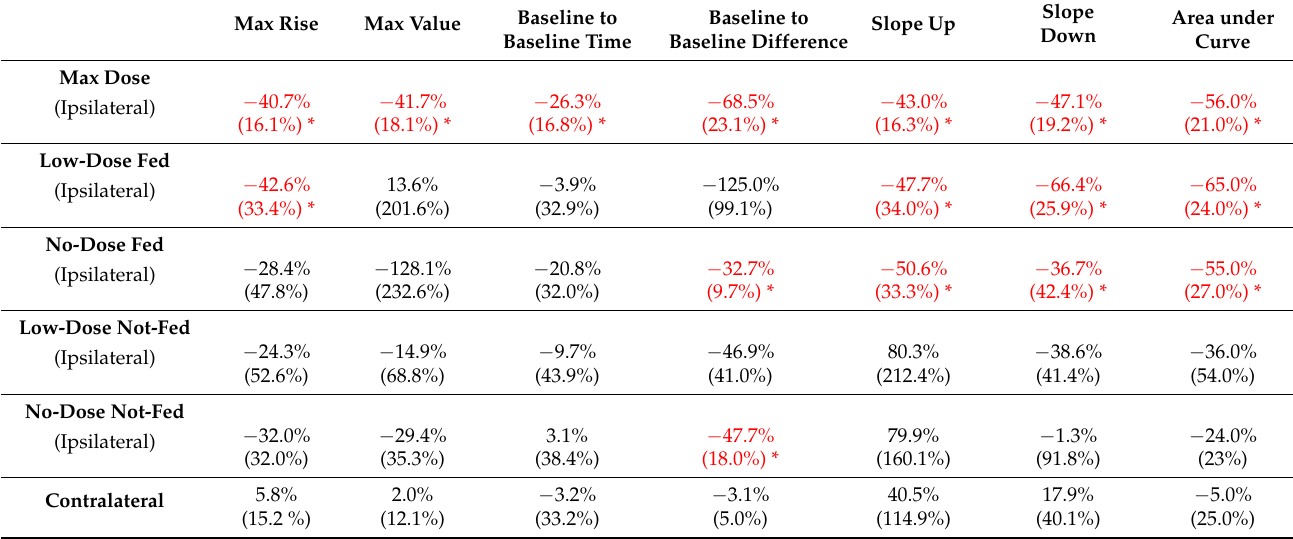
Table 2. Percent changes in each measurement for each of the 6 contours analyzed. Each entry is the average percent change and standard deviation of the percent changes in each of the 5 (or 4 in the case of the no-dose fed contour) swine. Each entry is in the form “Average (Standard Deviation)”. Statistically significant values (significant at the alpha = 0.05 level) are noted with a * and in red. Slope Baseline to Area under Max Rise Max Value Baseline to Slope Up Down Baseline Time Baseline Difference